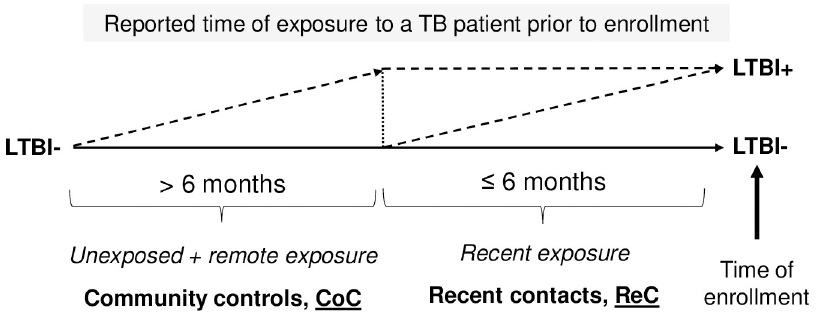
Fig 2. Definitions for community controls and recent contacts. Community controls were identified in the community (not in pulmonary clinics) and reported no previous exposure or a remote exposure to a pulmonary TB patient > 6 months before enrollment. Recent contacts reported exposure to an active TB case � 6 months before the time of enrollment. Community controls and recent contacts with at least one positive IGRA assay were classified as LTBI+, and when both negative, then as